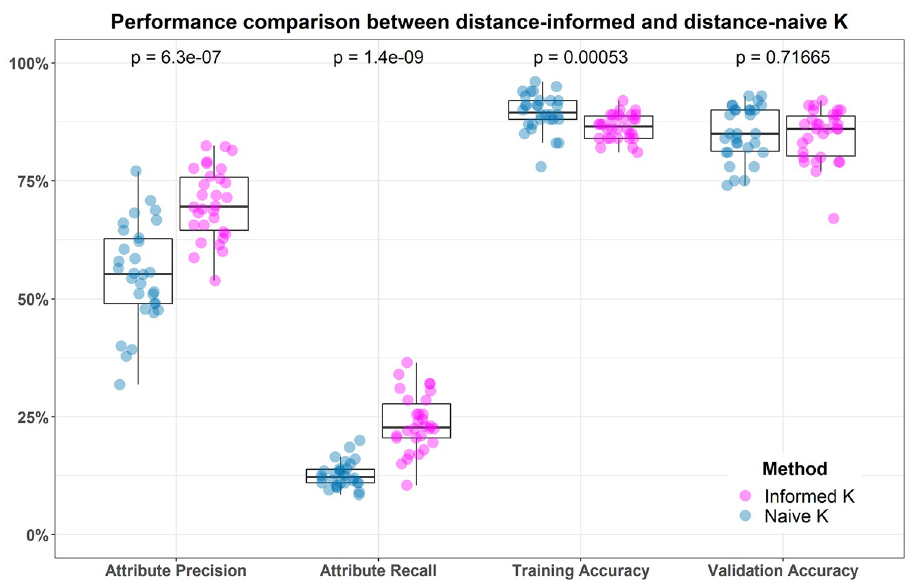
Fig 13. Simulation comparison between rule-of-thumb naive k = 10 and distance-distribution informed k α = 1/2 . Precision and recall for the functional features are significantly improved using informed k versus naive k = 10. The training and validation classification accuracy are similar for the two values of k with slightly less overfitting for informed-k.